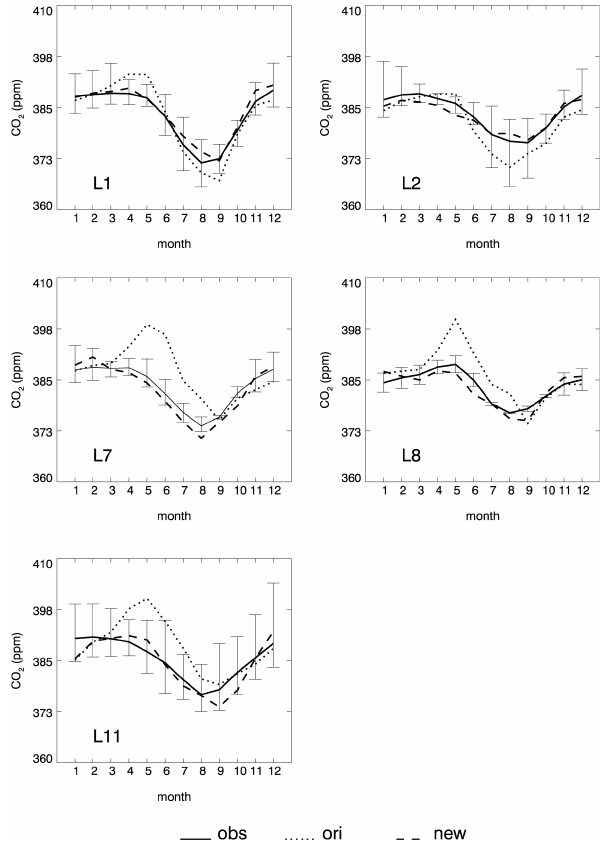
Fig. 7. Comparisons of regionally averaged values of CO 2 between model results from GEOS-Chem with the original emission inven- tory (dotted line) and the new emission inventory (dashed line) and GLOBALVIEW-CO 2 (solid line) for 5 land regions (L1: boreal North America, L2: temperate North America, L7: Eurasian boreal, L8: Eurasian temperate, L11: Europe) in 2006 (5 regions are shown in Fig. 4). The error bar represents the spread of the observations.